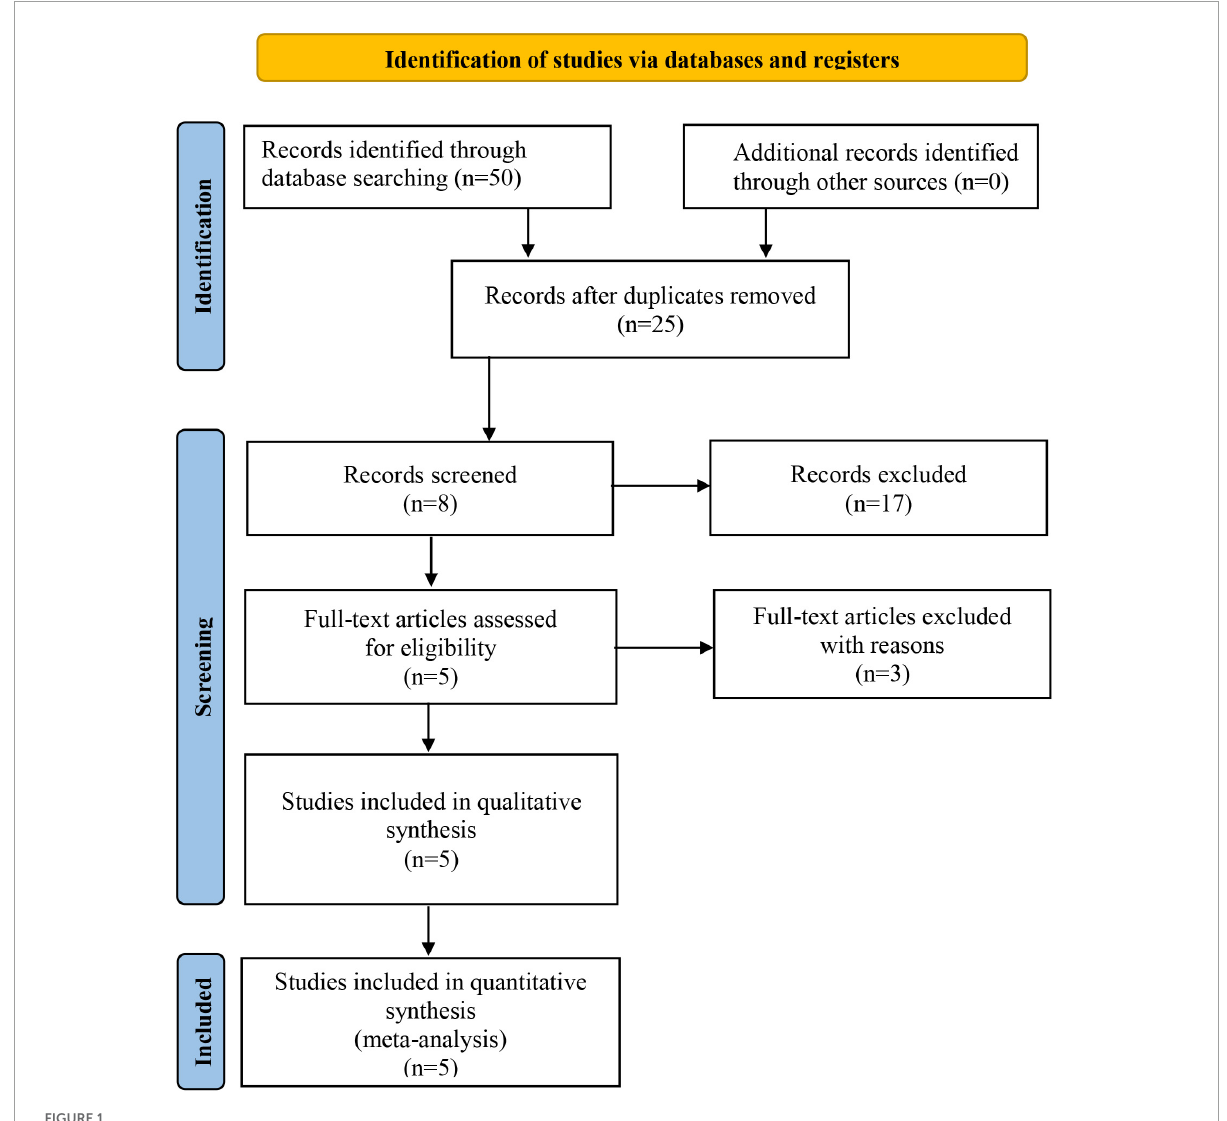
FIGURE1 Flow chart of literature screening.